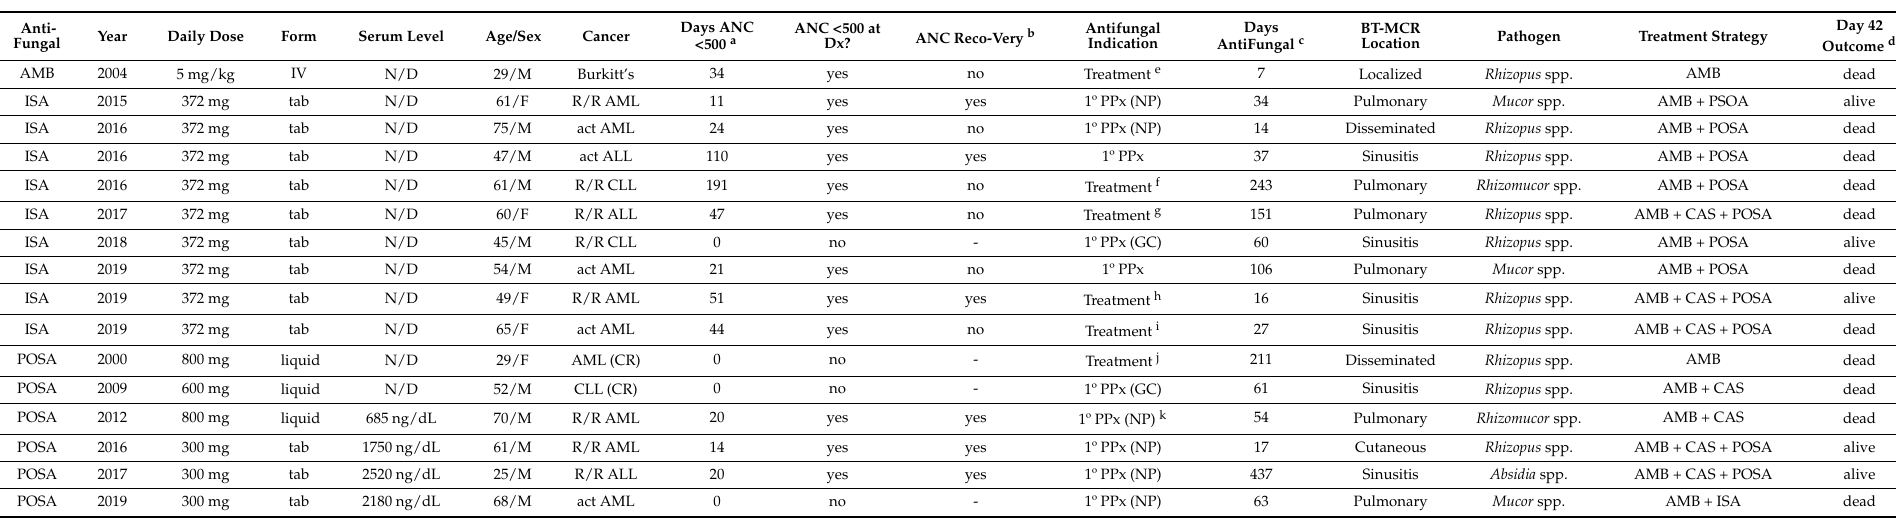
Table 2. Clinical characteristics of patients with breakthrough mucormycosis while receiving Mucorales-active